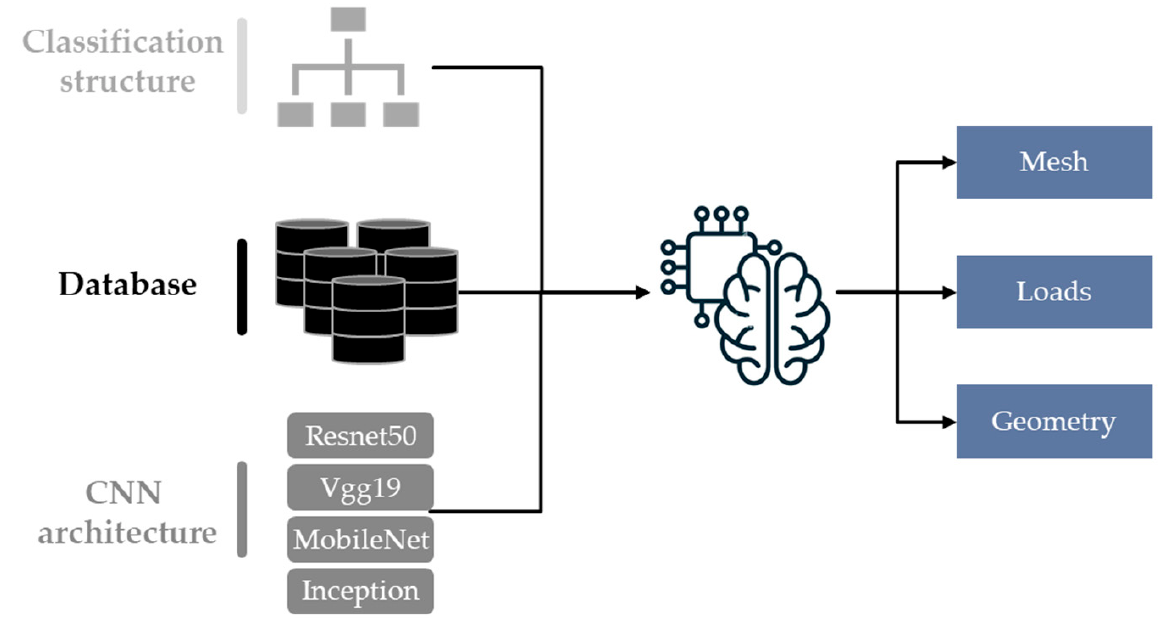
Figure 5. Overview of the relevant experiment parameters.